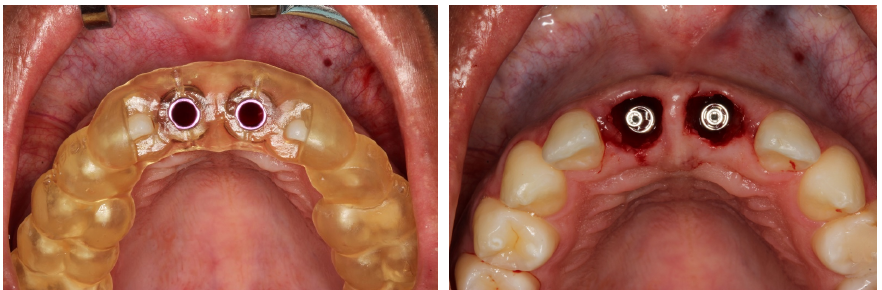
Figure 7. Installation of the surgical guide and Implants installed in the correct positioning and installation of cemented components.